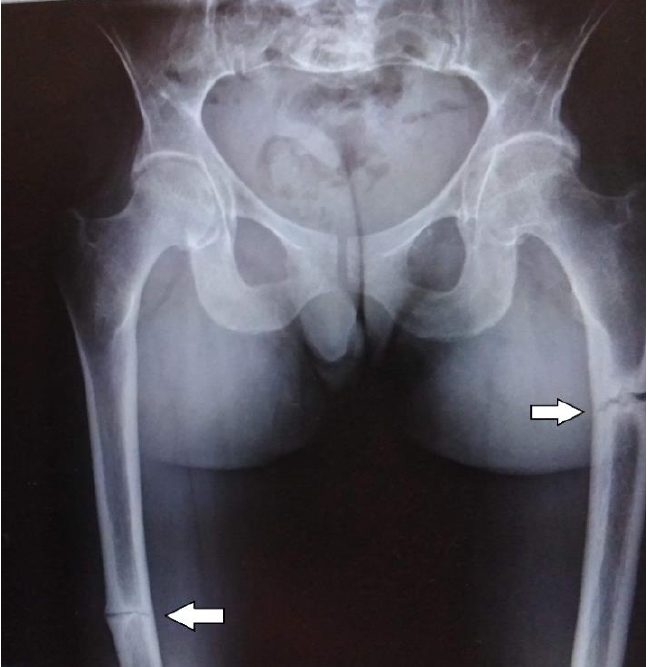
Figure 2. Fractures of the femurs in an adult patient with infantile HPP.